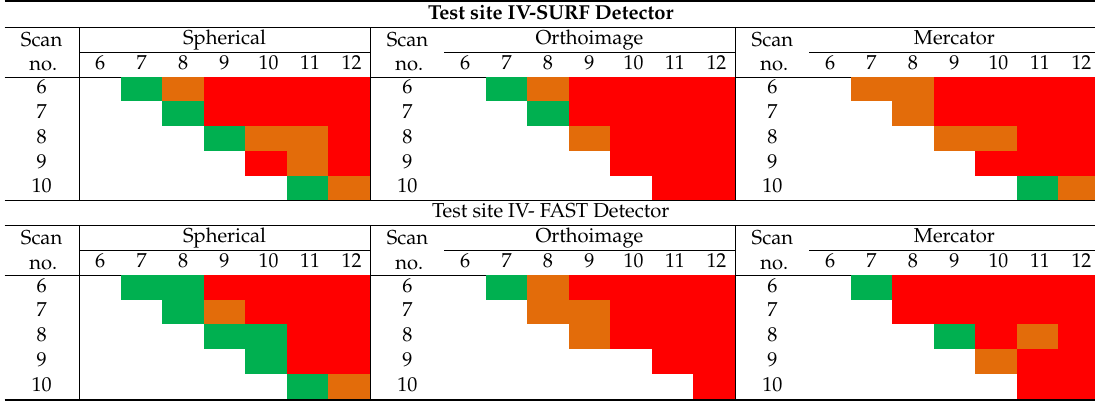
Table 8. The correctness of automated connecting of scans for Test Site IV (both scenarios): Green, correct matching (full-registration), orange, preliminary orientation requiring the final registration using the ICP method, red, no matching, and "x", means not a connection for scans (no overlap). Test site IV-SURF Detector Spherical Scan Orthoimage Scan Scan no. no. no.